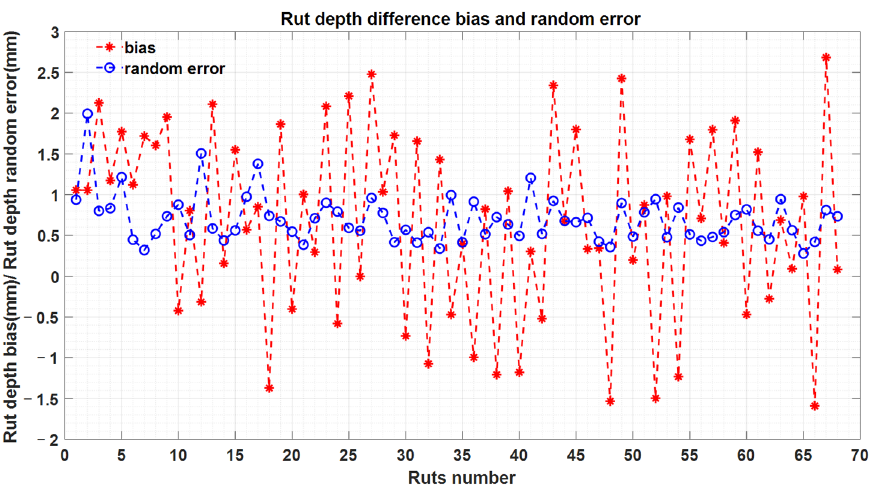
Figure 18. Bias and random error of the rut depth estimation.